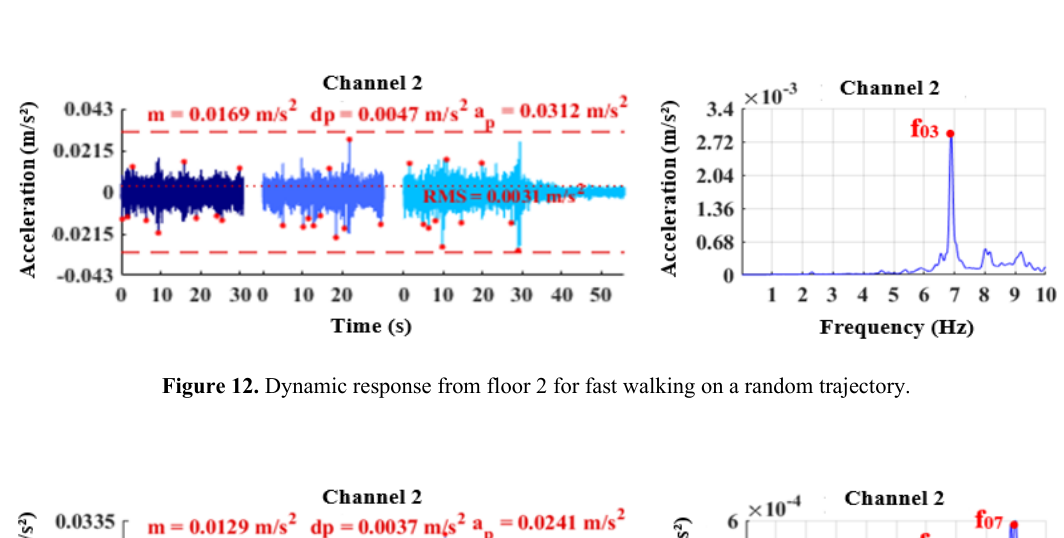
Figure 11. Dynamic response from floor 1 for fast walking on a random trajectory.